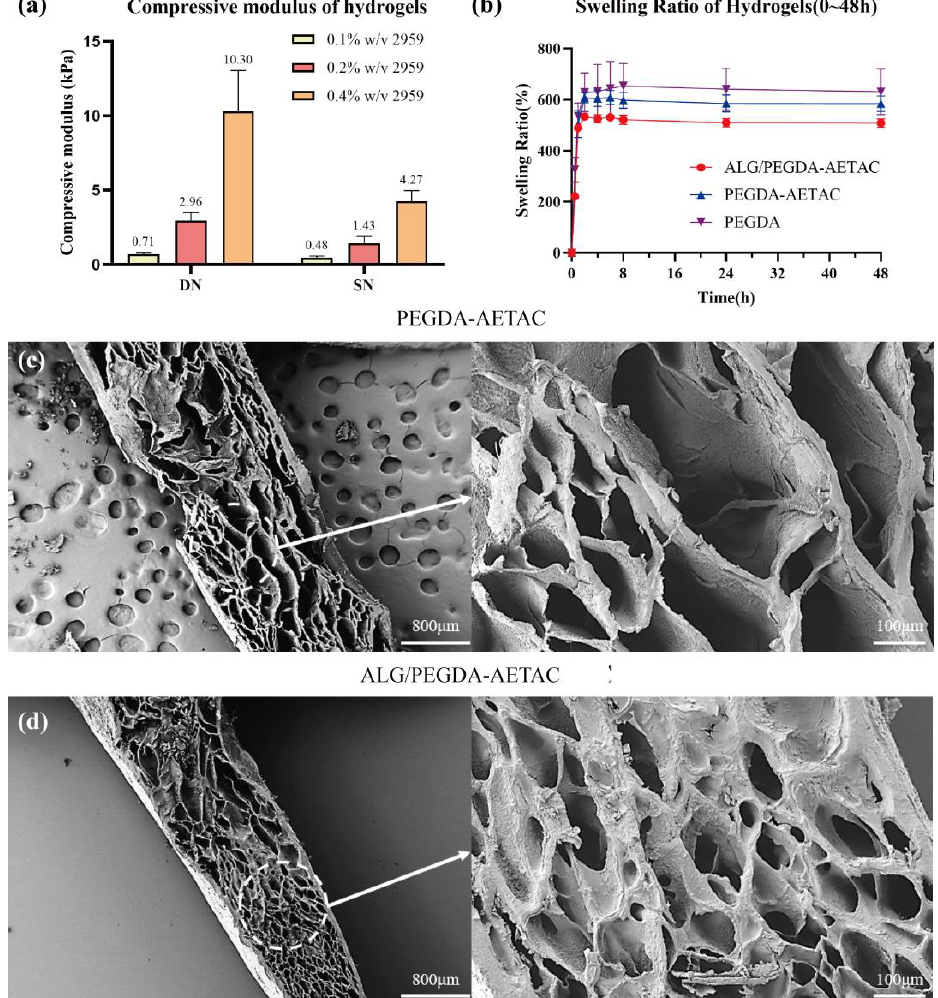
Figure 2. ( a ) Compressive modulus of different hydrogels. ( b ) Swelling ratio of different hydrogels. SEM images of ( c ) PEGDA-AETAC hydrogel and ( d ) ALG/PEGDA-AETAC hydrogel.